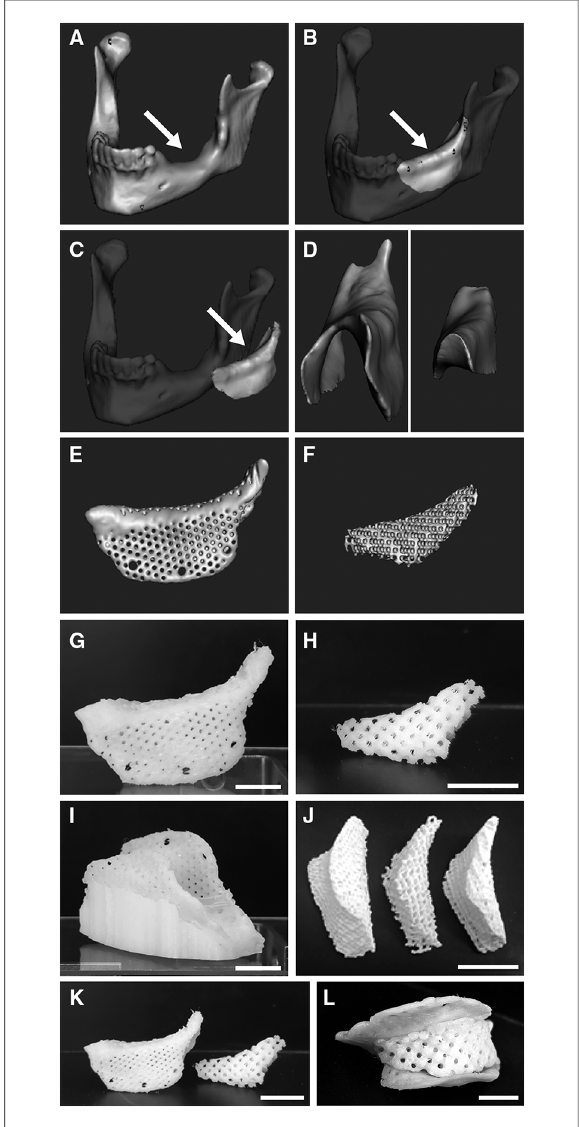
FIGURE 2 CAD and printed graft devices of a large mandibular bone defect. ( A – F ) CADs. ( A ) Defect with smooth bone surface (arrow). ( B ) Empty space leveled at the mandibular ridge to de fi ne the graft device (arrow). ( C ) Defect volume separated as virtual object to be processed individually (arrow). ( D ) Separation of the cover, representing the upper concave surface of the object (left), from the remaining core (right). ( E ) CAD of the device ’ s cover, provided with pores and anchoring screws holes. ( F ) CAD of a porous core. ( G – L ) Printed constructs. ( G ) The device ’ s PCL porous cover after removal from the scaffold and smoothing of surface details. ( H ) Printing of the porous core with PCL (1.5 mm interline distance). ( I ) Porous cover printed with PCL, shown while still in the co-printed supporting scaffold. ( J ) Porous cores printed with PLA at three porosities (1, 1.5 and 2 mm interline distance, from right to left). ( K ) Porous PCL core and porous PCL cover ( G,H , respectively) shown here together before assembly. ( L ) The PCL core fi tted into its cover as for surgical placement. Scale bars: ( G,I,L ), 10 mm; ( H,J,K ), 15 mm.